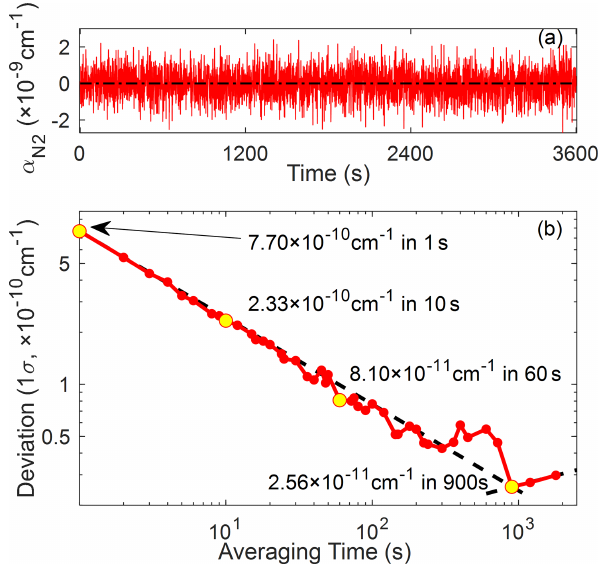
Figure 8. (a) Time series of light extinction for 1h of N 2 injection (1s integration) and its (b) Allan deviations (1 σ) for the single pixel at 662nm. Yellow circles represent deviations for 1, 10, 60, and 900s, respectively, and the dashed line indicates the theoretical limit representing white noise (slope: − 0 .